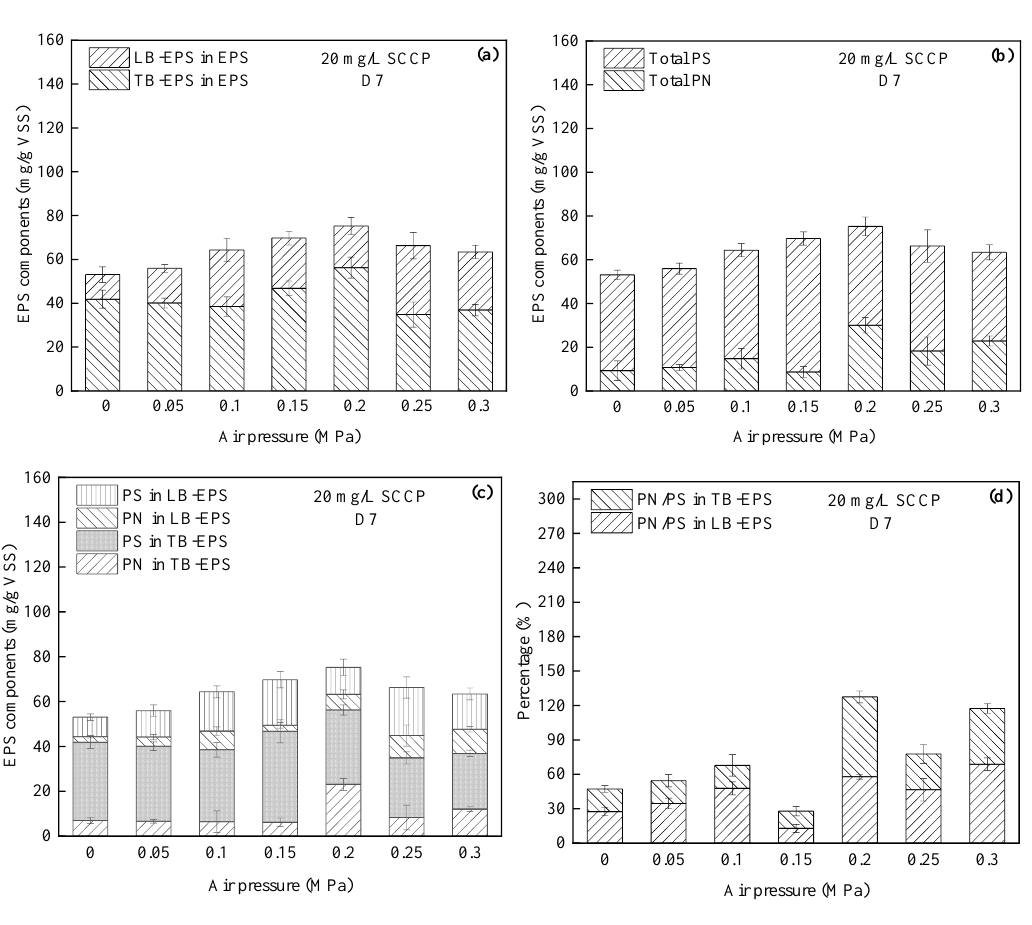
Figure 4. Relationship between different air pressures and ( a ) LB-EPS and TB-EPS components; ( b ) PS and PN components; ( c ) EPS components; and ( d ) PN/PS ratio of EPS in a pressurized reactor. EPS, extracellular polymeric substances; PN, proteins; PS, polysaccharides. Table 1. Comparison of the parameters of pure oxygen and air